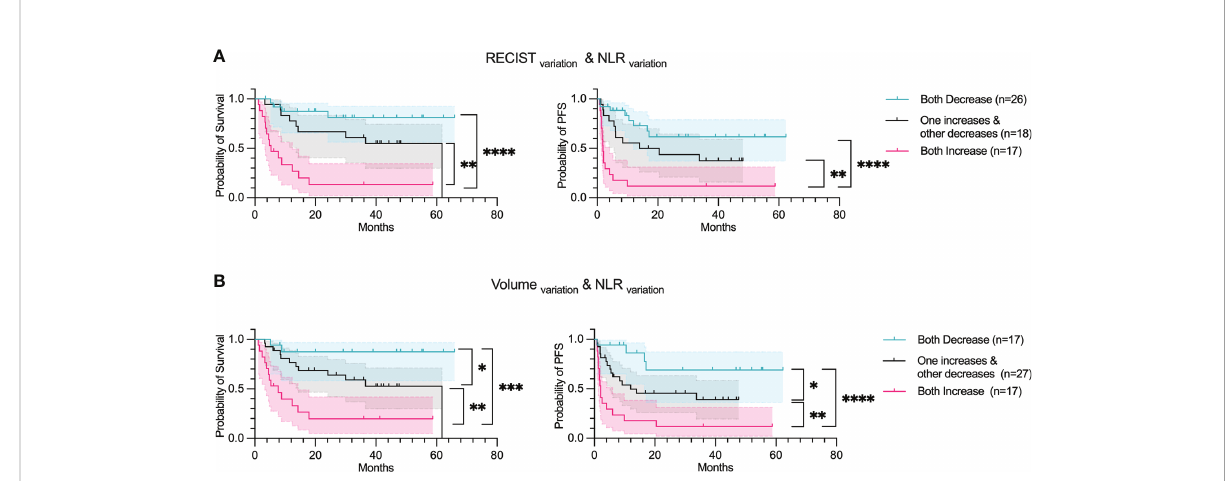
FIGURE 6 Concordance score predicts OS and PFS. Overall survival and Progression-free survival plotted using a Kaplan-Meier estimation with their respective con fi dence intervals (95%). The parameters studied are: (A) Concordance score using RECIST variation & NLR variation . (B) Concordance score using Tumor volume variation & NLR variation . For Kaplan – Meier estimation, tick marks represent data censored at the time of the last imaging assessment and statistical analyses were performed using Log-rank (Mantel-Cox) test. Symbol signi fi cance: * p ≤ 0.05; ** p ≤ 0.01; *** ≤ 0.001, **** ≤